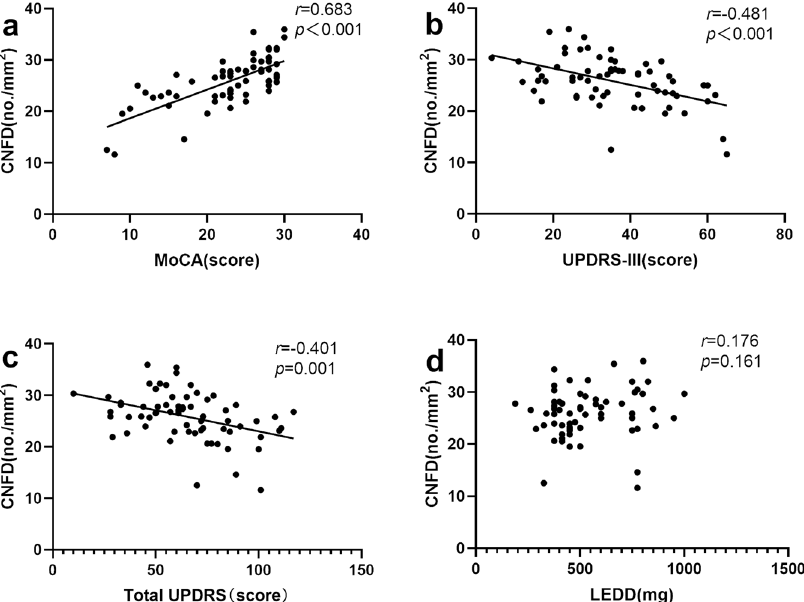
Fig. 4 Association between CNFD with MoCA, part III and total UPDRS score and LEDD. The correlation was performed with Pearson ( a , d ) or Spearman ( b , c ) correlation analyses with standardized correlation coef fi cients Abbreviations: CNFD corneal nerve fi ber density, MoCA Montreal cognitive assessment, UPDRS uni fi ed Parkinson ’ s disease rating scale, LEDD levodopa equivalent daily